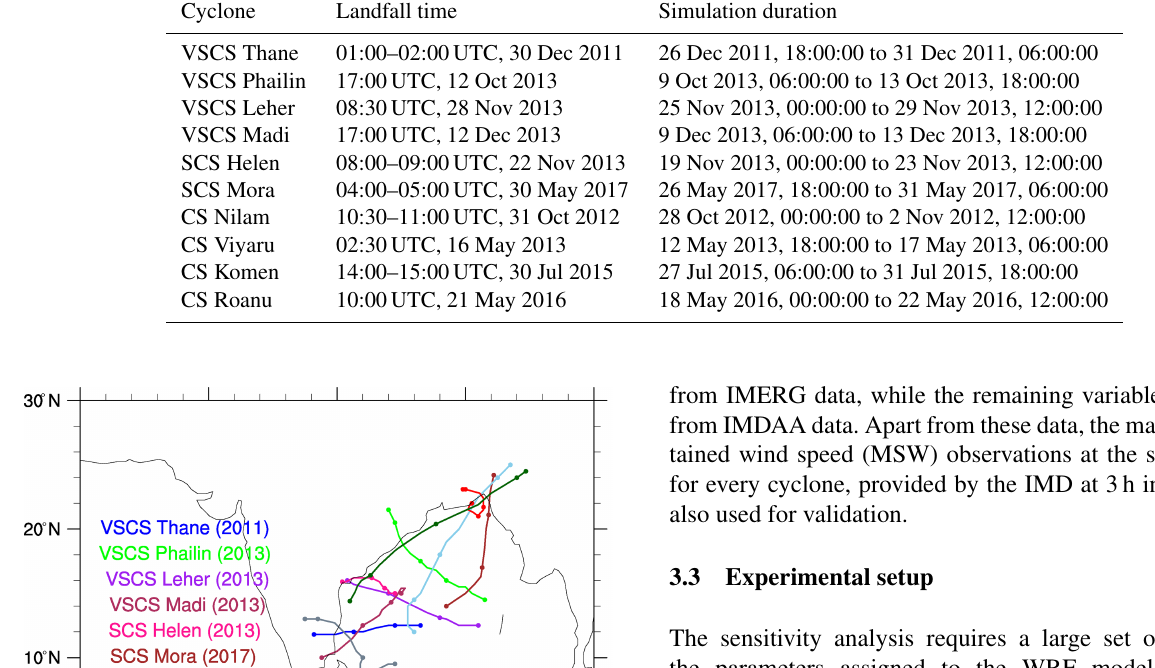
Table 2. Details of the tropical cyclones selected in this study. Cyclone